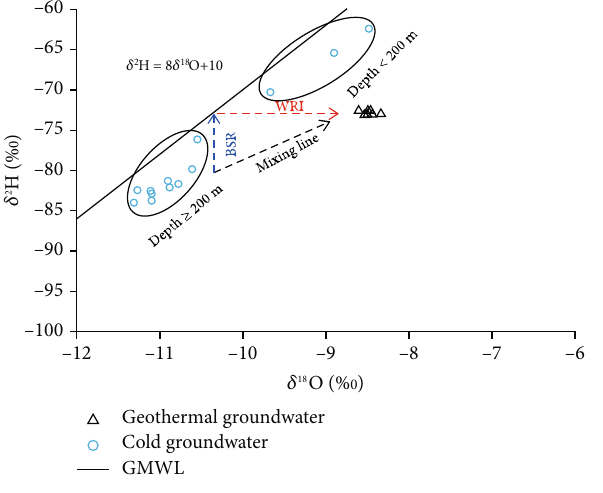
Figure 6: Isotopes of cold groundwater and geothermal groundwater at Xiongxian. The dashed lines are the possible processes: red line indicates the oxygen shift due to water-rock interaction (WRI); the dashed blue line shows the hydrogen shift due to inferred bacterial sulphate reduction (BSR); and the dashed black line is the mixing